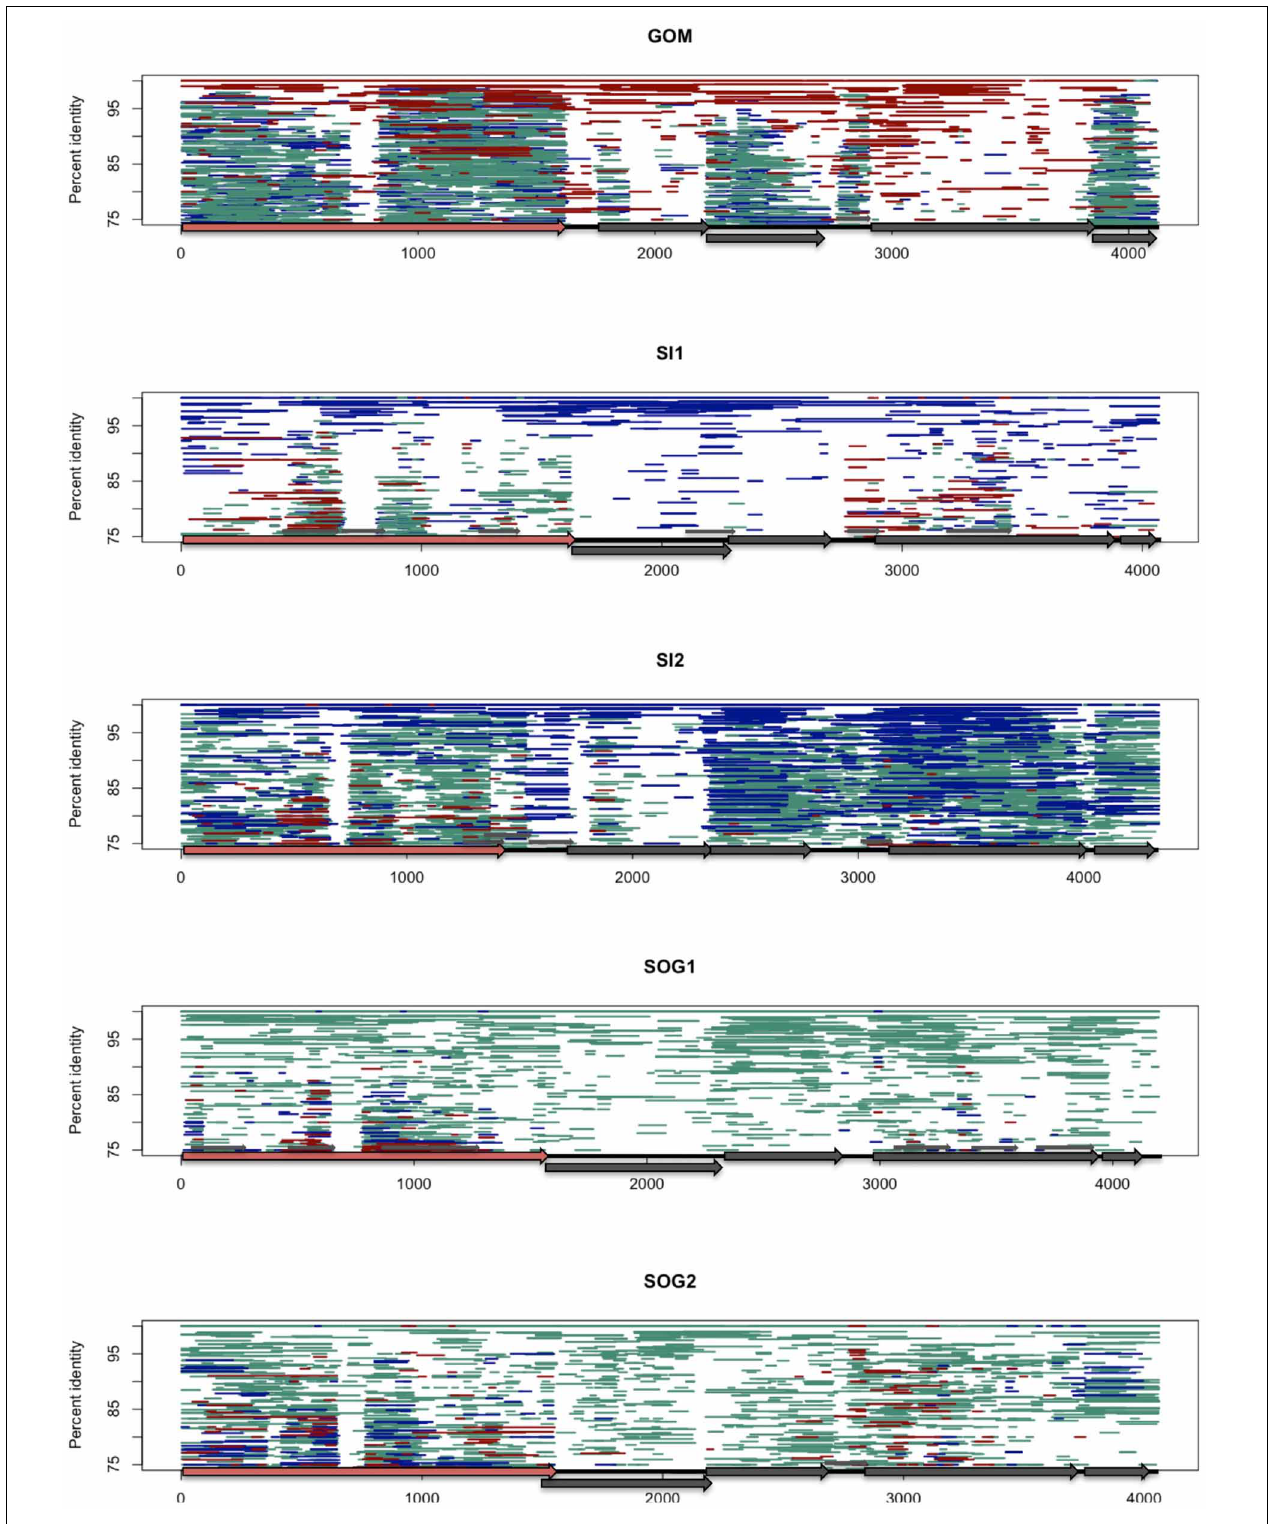
FIGURE 3 | Fragment recruitment of the viral ssDNA reads on the genomes from this study to show regions of conservation among ssDNA gokushoviruses. Each assembled genome (GOM, SI1, SI2, SOG1, SOG2) is represented by a different panel. Each horizontal line represents a metagenomic read from ssDNA data